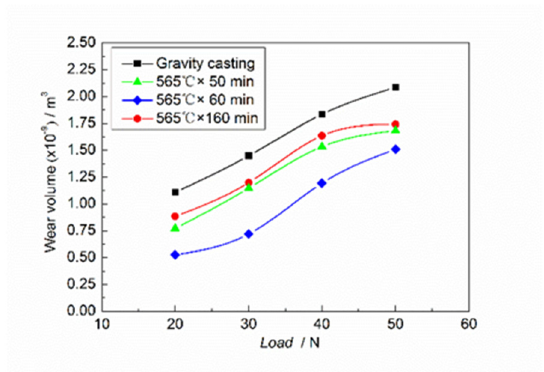
Figure 4. Curves of Mg 2 Si–Al composites fabricated by using gravity casting and semi-solid extrusion with isothermal heat treatment holding times of 50 min, 60 min, and 160 min between wear volumes and applied load.